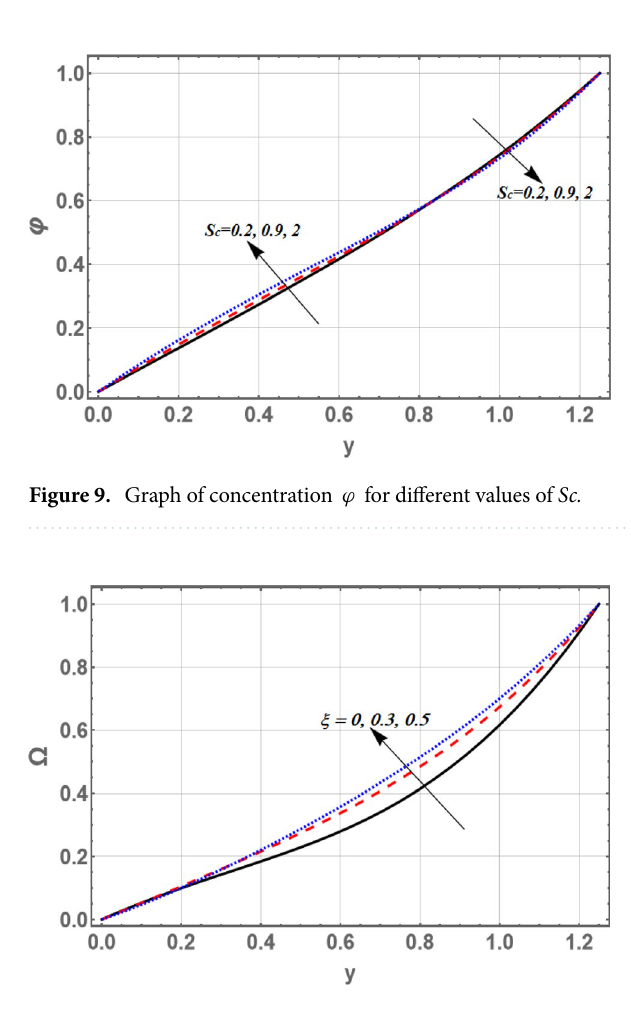
Figure 10. Graph of nanoparticles volume friction (cid:31) for different values of ξ .